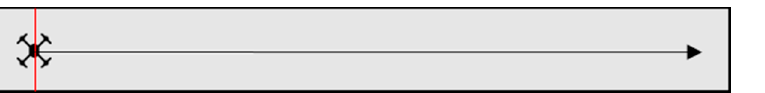
Figure 1. A monitoring route using the line transect method. The gray area is the monitoring area.